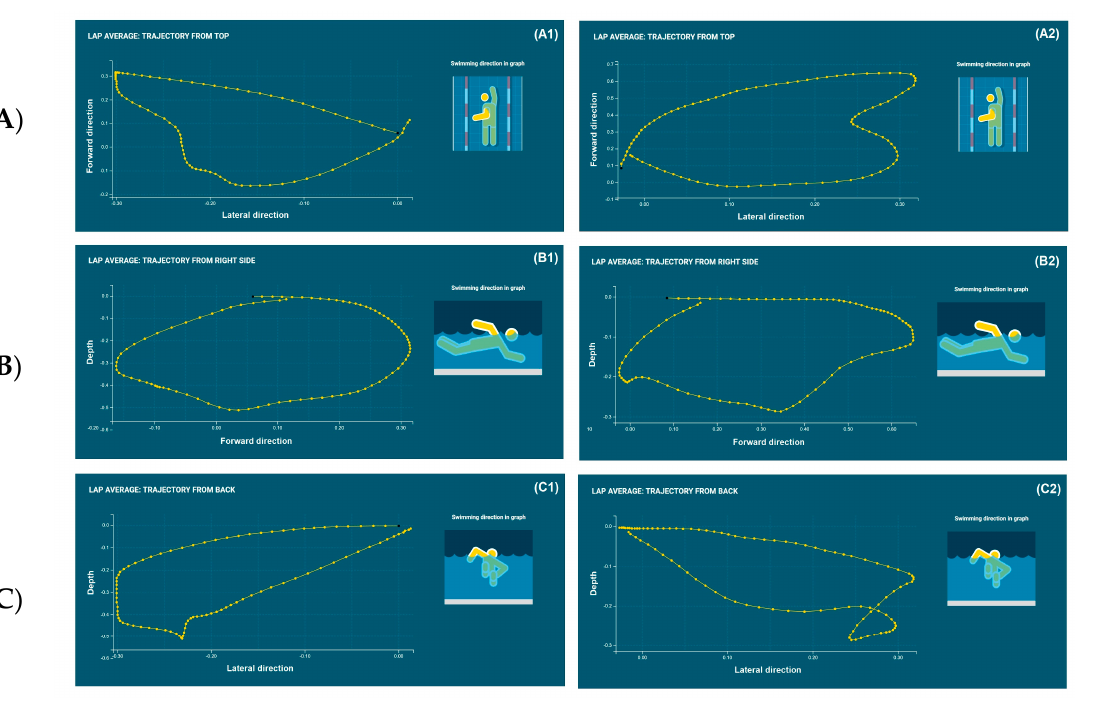
Figure 4. Example of a swimmer’s hand trajectory that can be analyzed in the Analysis Center. Suffixes 1 and 2 correspond to the left and right hand, respectively. Panels ( A )—top view of the arm-pulls. Panels ( B )—side view of the arm-pulls. Panels ( C )—back view of the arm-pulls.